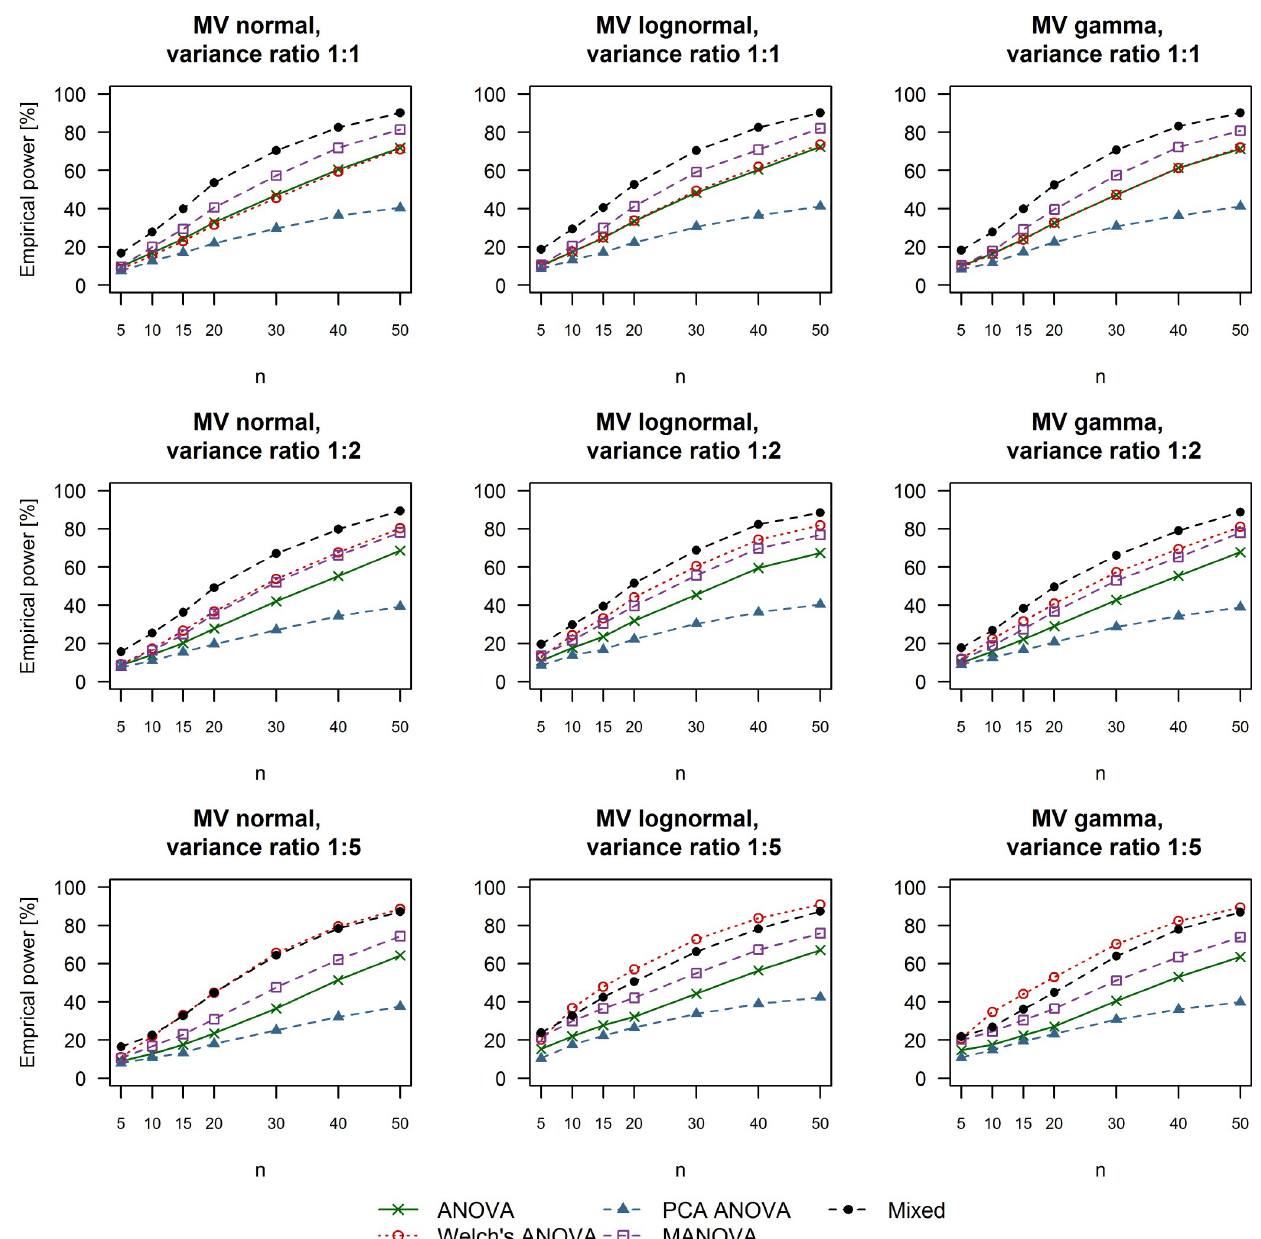
Fig 4. Empirical power of univariate and multivariate techniques in case of moderate treatment effects (Cohen’s d equal to 0.5). The multivariate distribution from which the data were drawn as well as the variance ratio between simulated control and treatment groups are summarized in the title of each respective plot. ANOVA: Analysis of variance; MANOVA: Multivariate analysis of variance; Mixed: Linear mixed effects model; MV: Multivariate; PCA: Principal component analysis.